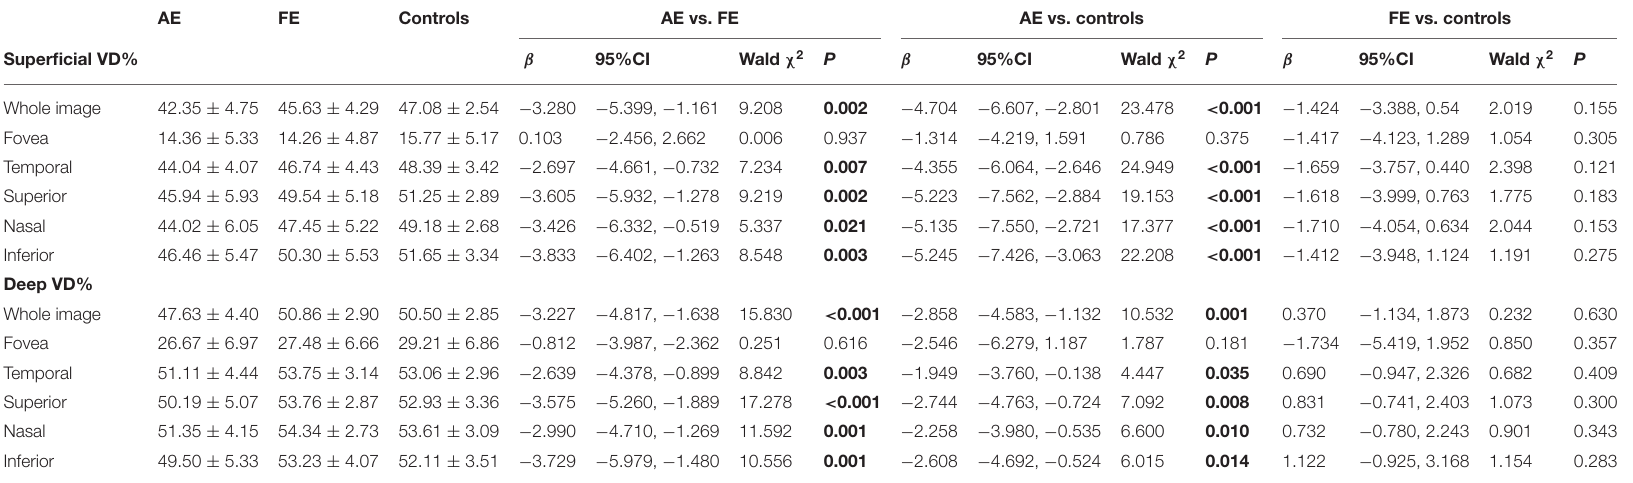
Values are depicted as mean ± SD. GEE analyses, AE, FUS-affected eyes of patients; FE, fellow eyes of patients; VD, vascular density; GEE, generalized estimating equation; CI, confidence interval; β , regression coefficient; and p, the value of p. Bold values indicate a statistical significance of p < 0.05.